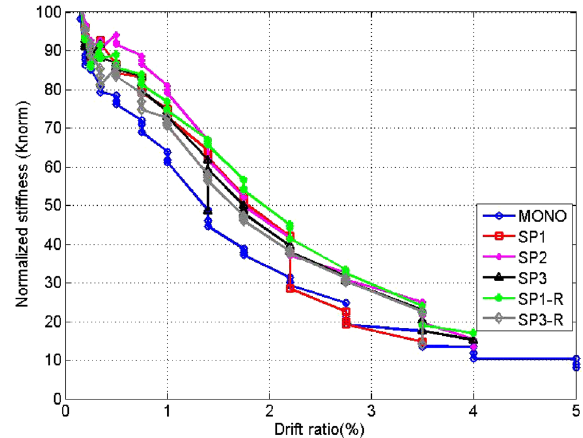
Fig. 23 Normalized secant stiffness (K sec ) of test specimens for corresponding drift ratios.